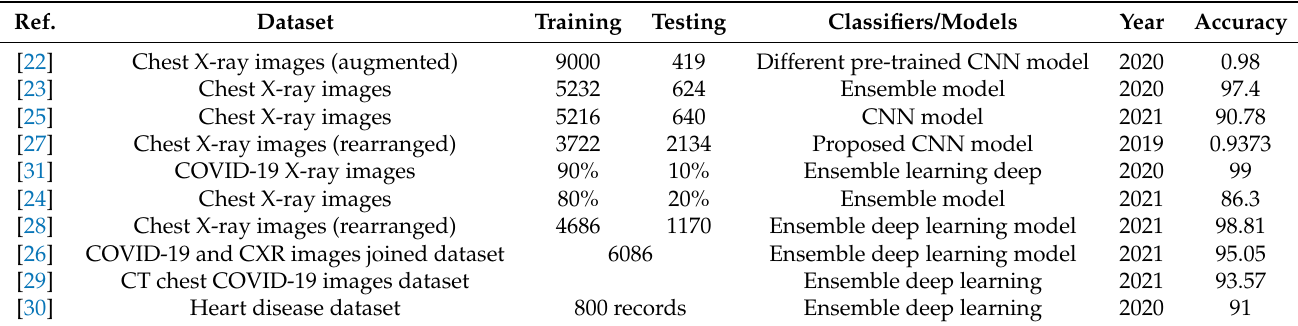
Table 1. Summary of the related work.